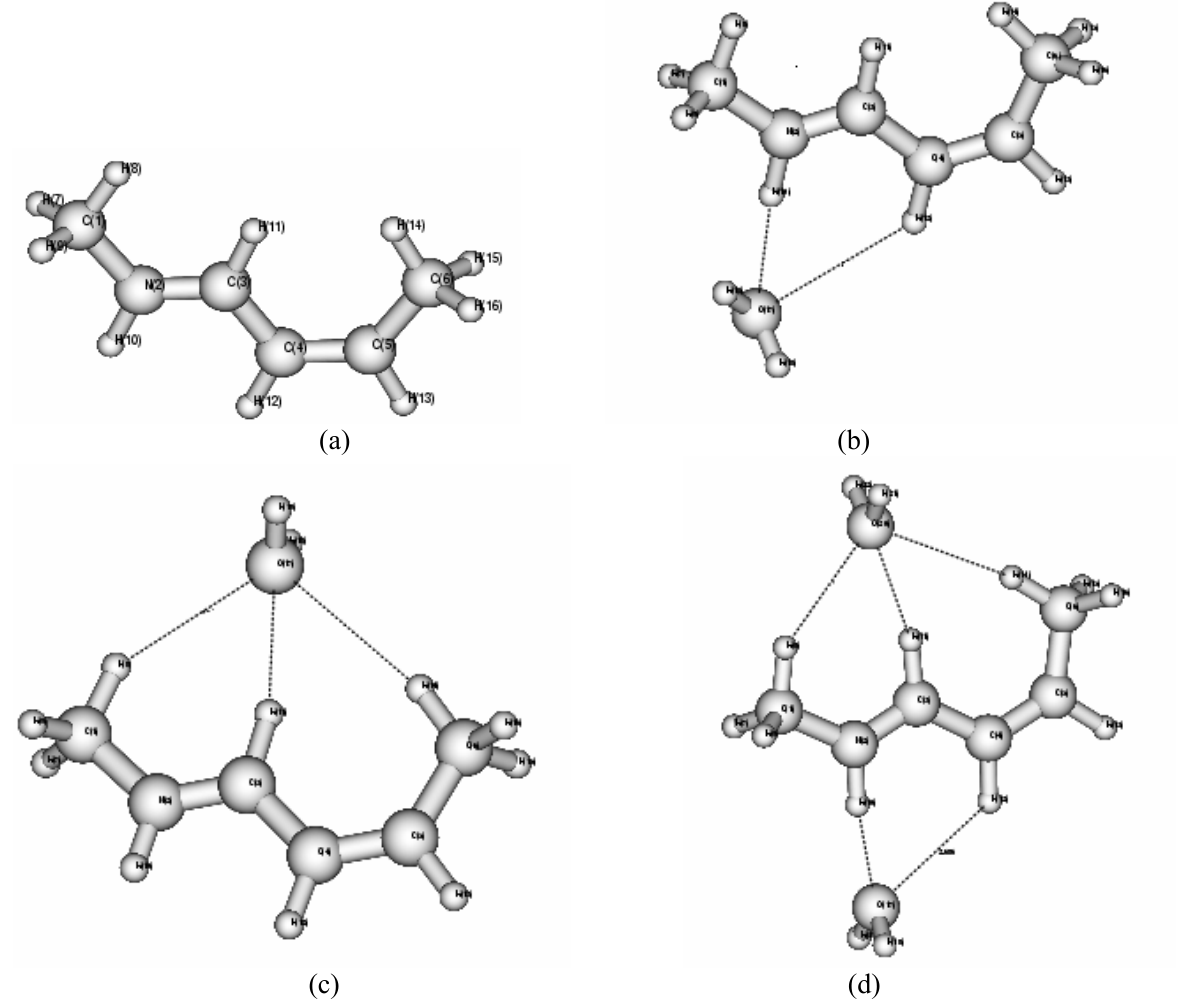
Figure 2. Molecular structures of (a) NMB (b) NMB-water along NH side (c) NMB-water along CH side (d) NMB-water at both the sides.